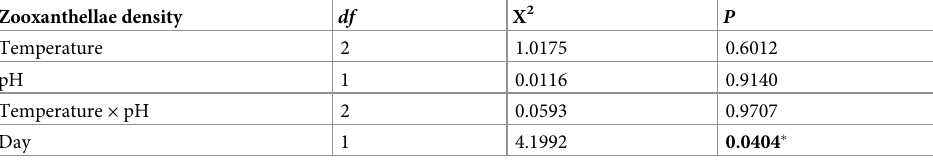
Table 6. Summary of results of the linear mixed-models analysis of the zooxanthellae density (mm 2 ) (n = 122). Zooxanthellae density df X 2 P Temperature 2 1.0175 0.6012 pH 1 0.0116 Temperature × pH 2 0.0593 0.9707 Day 1 4.1992 0.0404 � Chisq = X 2 , df = degrees of